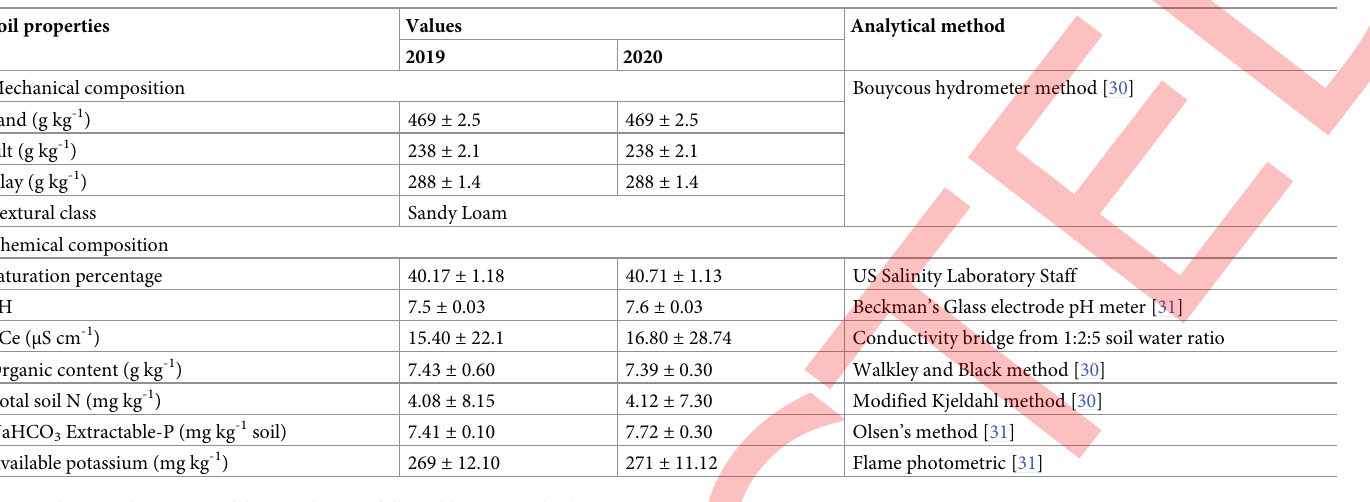
Table 1. Physio-chemical characteristics of the experimental site at College of Agriculture, University of Sargodha, Sargodha, Pakistan. Soil